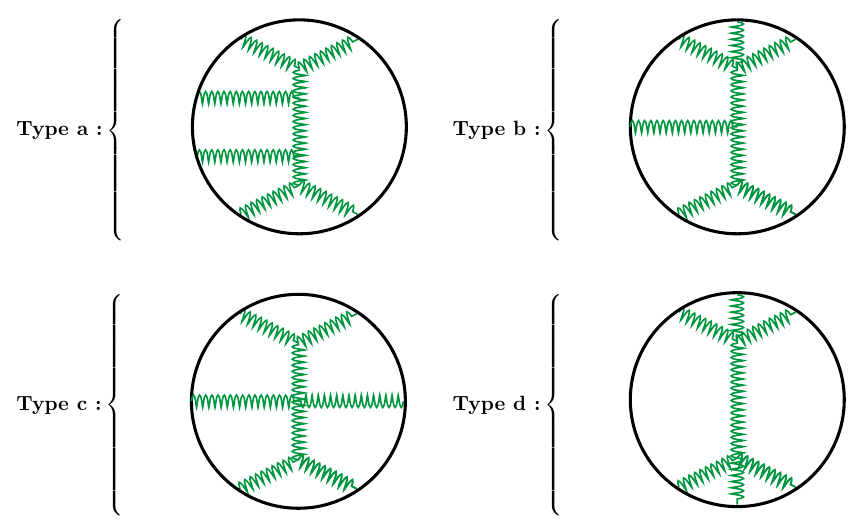
1 Figure 6 . Topologies for six point vector